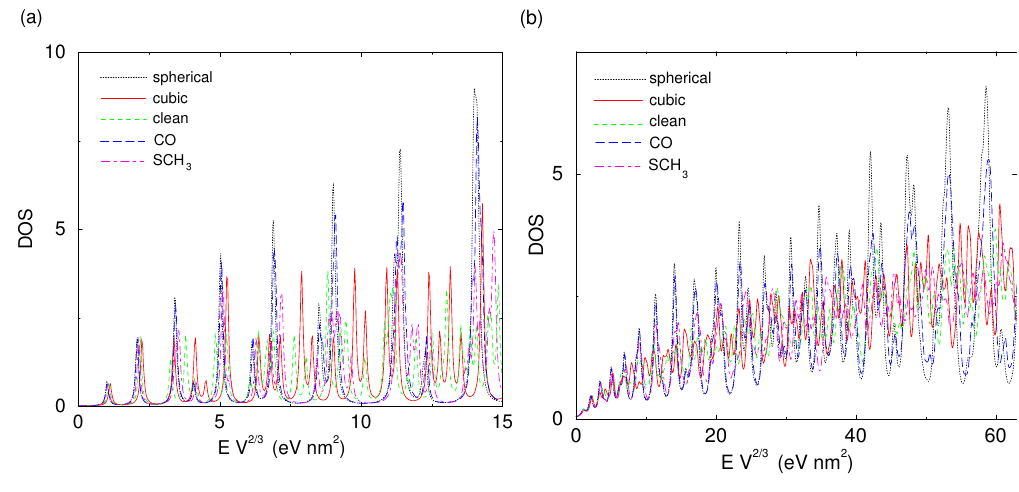
Figure 6. The DOS per volume of all shapes considered in this study: spherical (dotted black line), cubic (red line), clean (dashed green line), CO-covered (long-dashed blue line), and thiolate-covered (dot-dashed purple line). DOS has been calculated using Lorentzian broadening of either 1 meV ( a ) or 5 meV ( b ). The energies have been multiplied by the volume of the nanoparticle to the exponent 2/3.